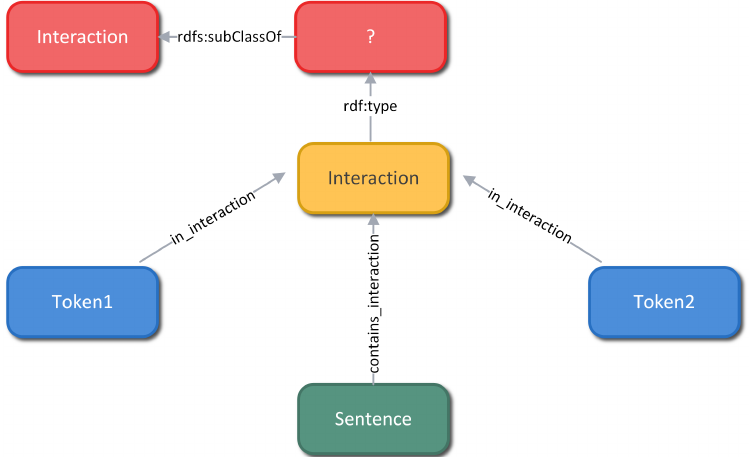
Figure 3. The schema of subgraph G which models the classification of an Interaction